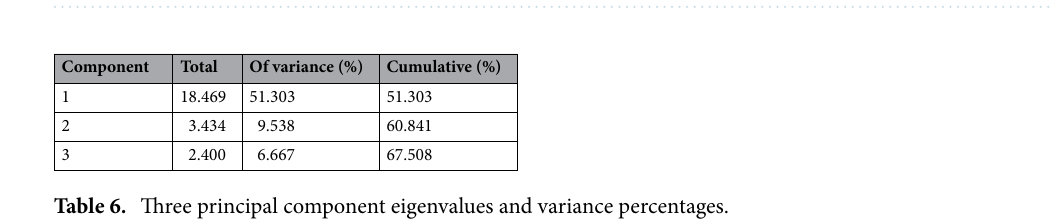
Figure 2. Scree plot. Note The vertical axis is the eigenvalue and the horizontal axis is component.